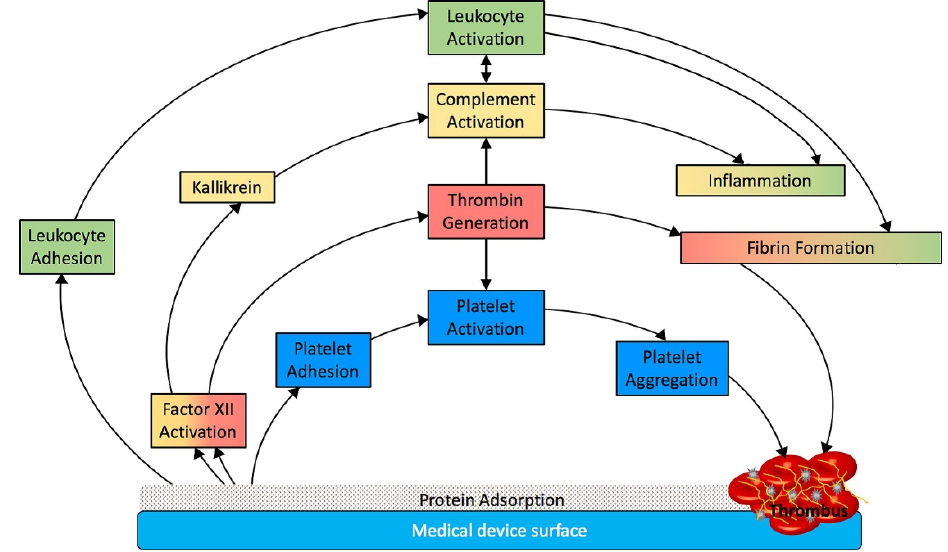
Figure 1. Activated pathways and their interplay during the interaction of blood components with artificial surfaces like the dialysis membrane material. Reproduced from reference 23 (with permission of authors and